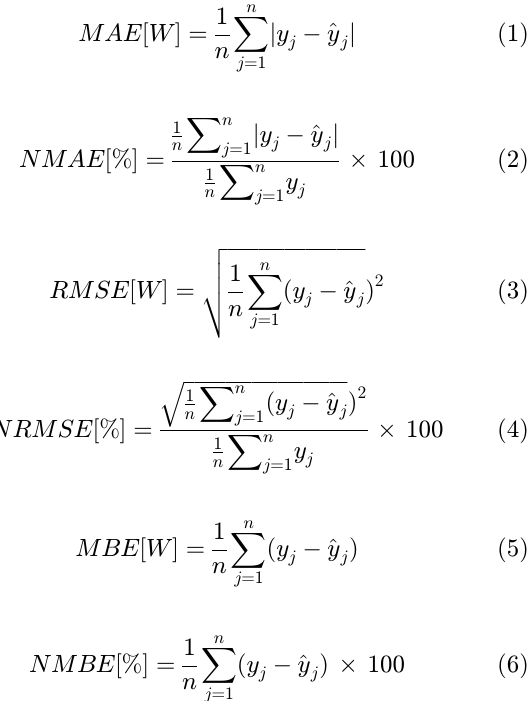
ffiffiffiffiffiffiffiffiffiffiffiffiffiffiffiffiffiffiffiffiffiffiffiffiffiffiffiffiffiffiffiffi 1